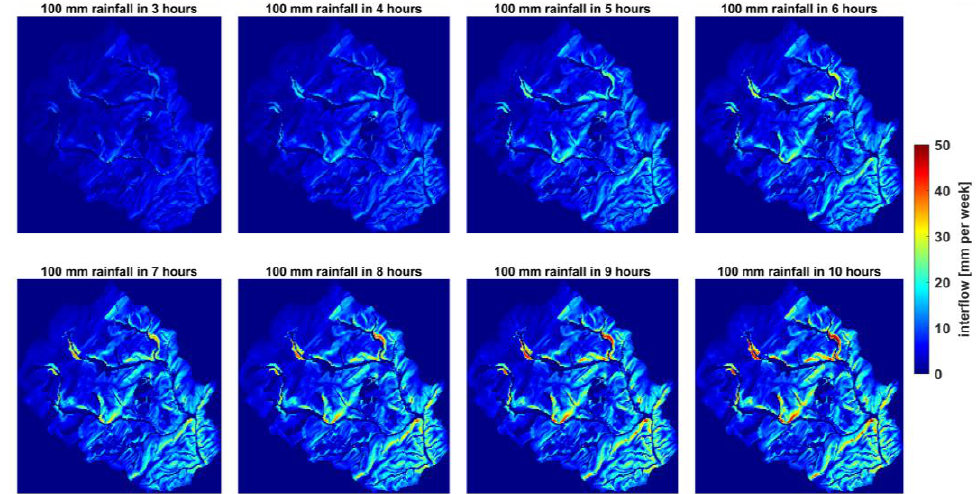
Figure 4. Variability in the spatial patterns of simulated interflow within the catchment, under different synthetic rainfall intensities (PTF combination 5 from Table 1).